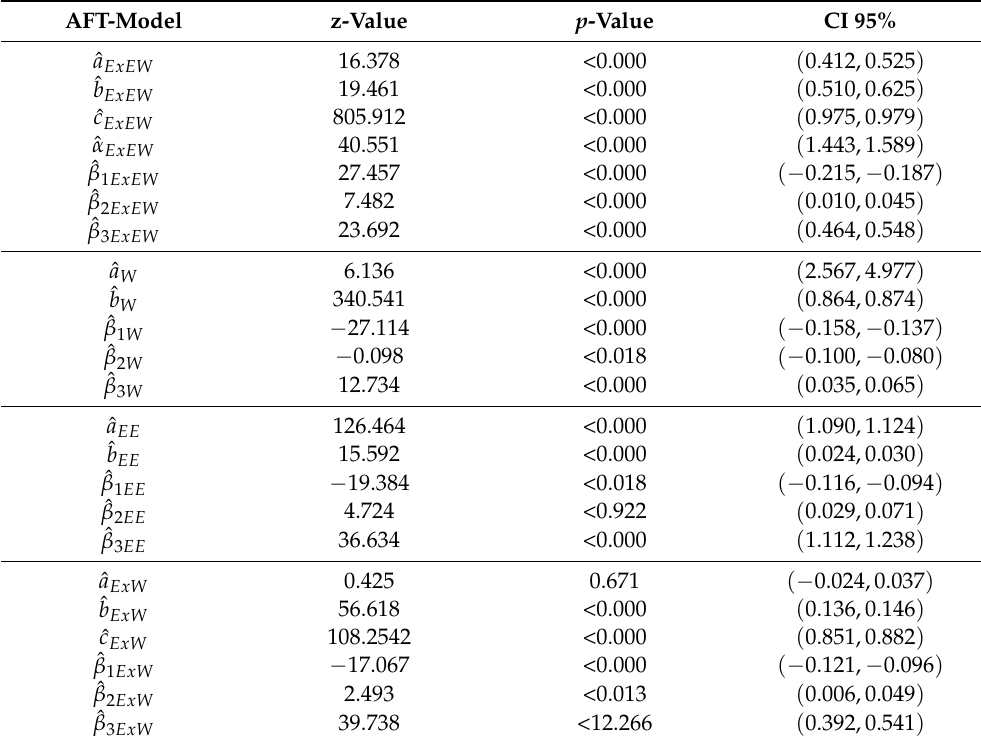
Table 22. z-value, p -value, and confidence interval (CI) for the AFT estimates for each model at the level of significance 5%.